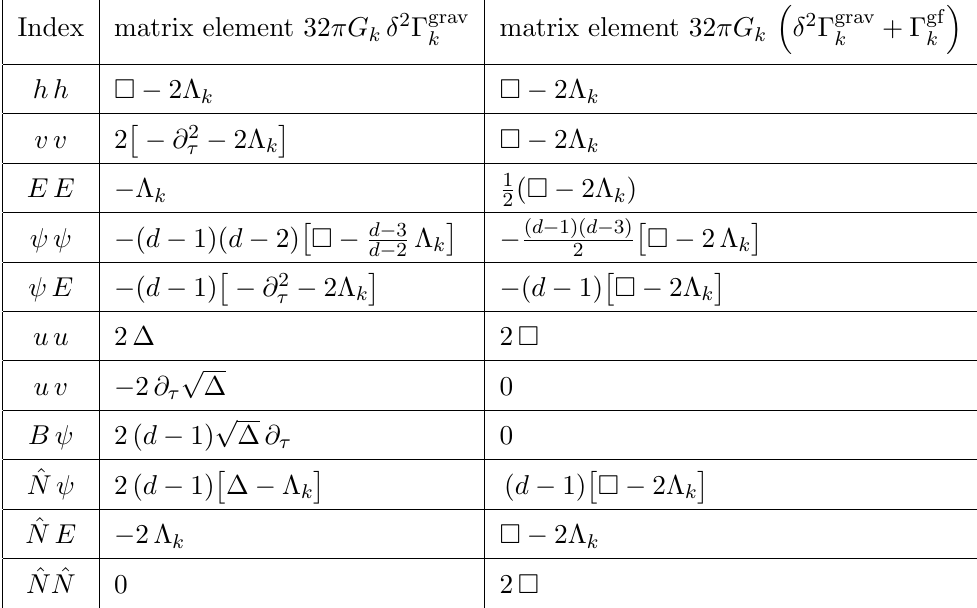
(cid:0) (cid:22) (cid:27) ij @ i @ j . For each \o(cid:11)-diagonal" t